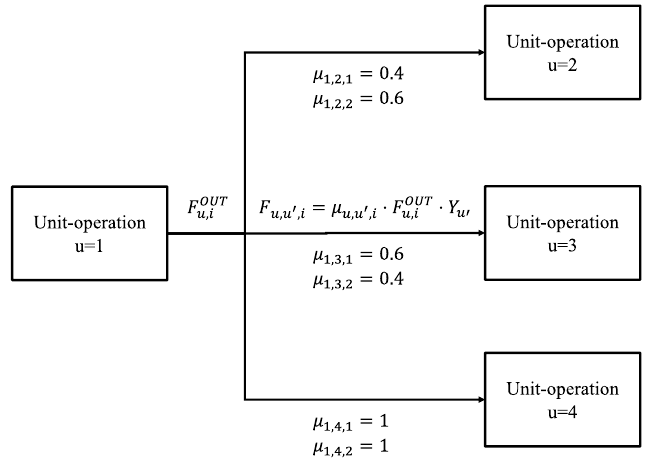
Figure 10. Example topology based on classic split factors.